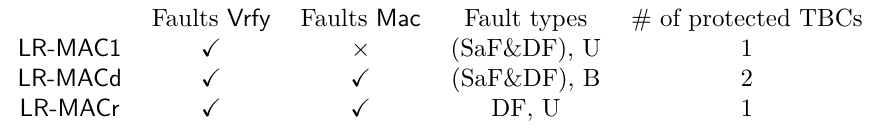
Table 1: Summary of our constructions. The column ‘Faults Vrfy ’ says whether the scheme is secure when the adversary can only inject faults in tag verification. The column ‘Faults Mac ’ says whether the scheme is secure when the adversary can also inject faults in tag generation. The column ‘Fault types’ describes the type of faults where SaF stands for Stuck-at-Faults, DF stands for Differential Faults, and U / B stand for unbounded / bounded number of faults. The column ‘#TBC’ is the number of protected TBC calls. Faults Vrfy Faults Mac Fault types # of protected